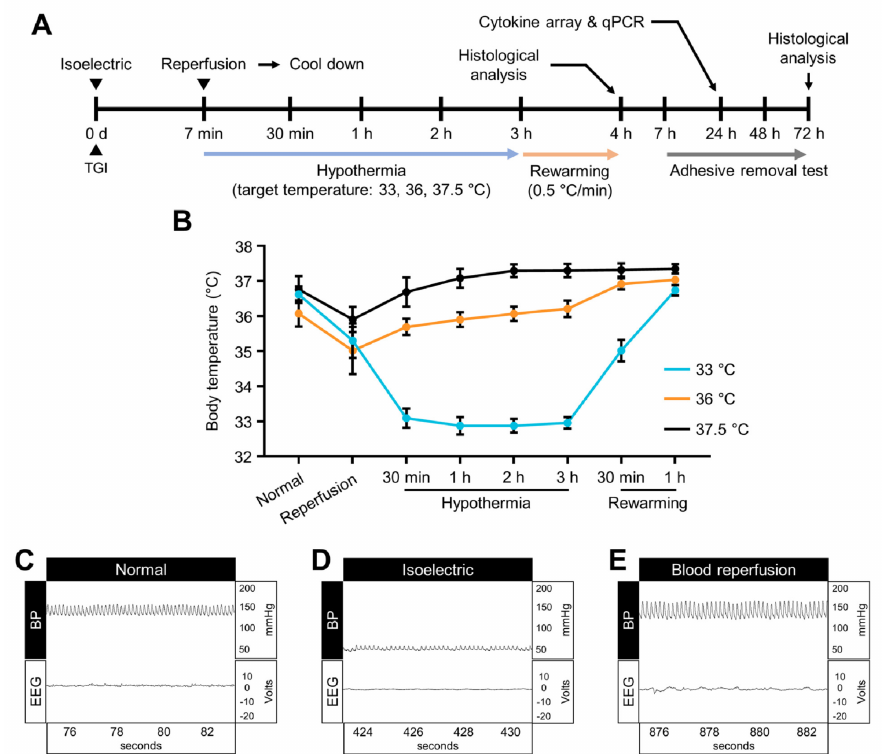
Figure 7. Experimental design for targeted temperature management (TTM). ( A ) Timeline represent- ing the entire experimental design following TTM. After termination of TTM, several analyses were conducted to verify the effects of TTM. ( B ) Changes of systemic body temperature during TTM. ( C – E ) Arterial blood pressure and electroencephalograph pattern during transient global ischemia. Before initiation of the set isoelectric point; blood withdraw range 40 (diastolic) to 50 (systolic) mmHg. Blood pressure and electroencephalography findings were completely restored after blood reperfusion. Targeted temperature management (TTM) at 33 ◦ C and 36 ◦ C decreases hippocampal neuronal